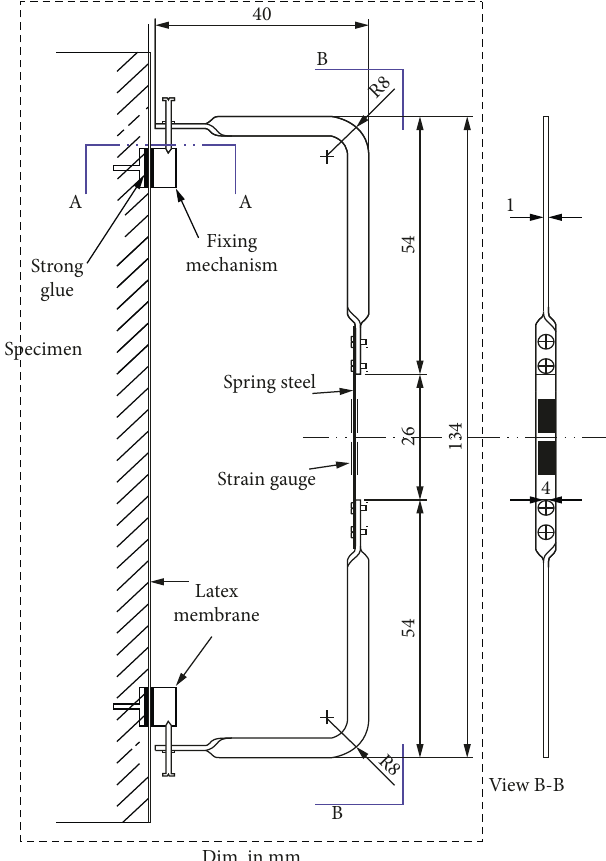
Figure 1: Axial spring deformation gauge used in this